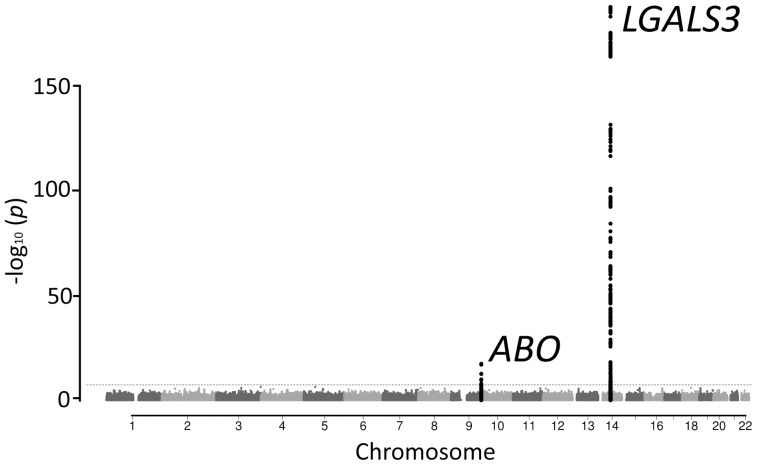
Manhattan plot showing the association of SNPs with circulating galectin-3 levels in a GWAS of 3,776 individuals.The red dotted line marks the threshold for genome-wide significance (P = 5×10−8). Two loci reached genome-wide significance.